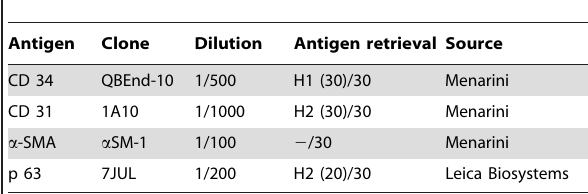
Table 1. Antibodies used in this